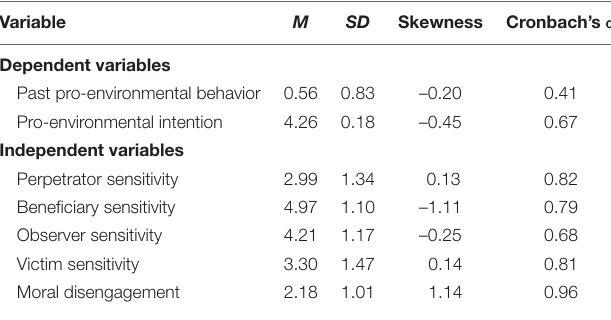
Skewness Cronbach’s